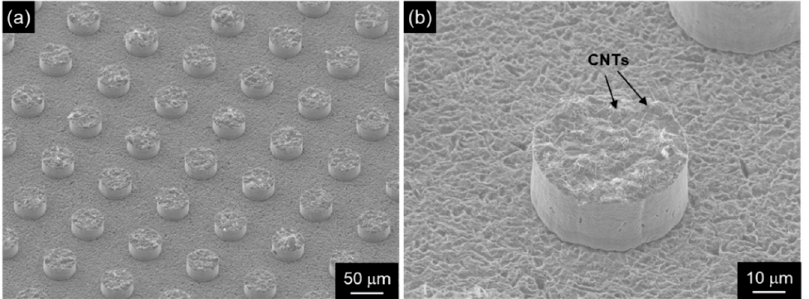
Figure 9. SEM images of patterned CNT emitters fabricated by composite plating assisted with photolithography: ( a ) low magnification, ( b ) high magnification. (Figure 9 is adapted from reference [73]).